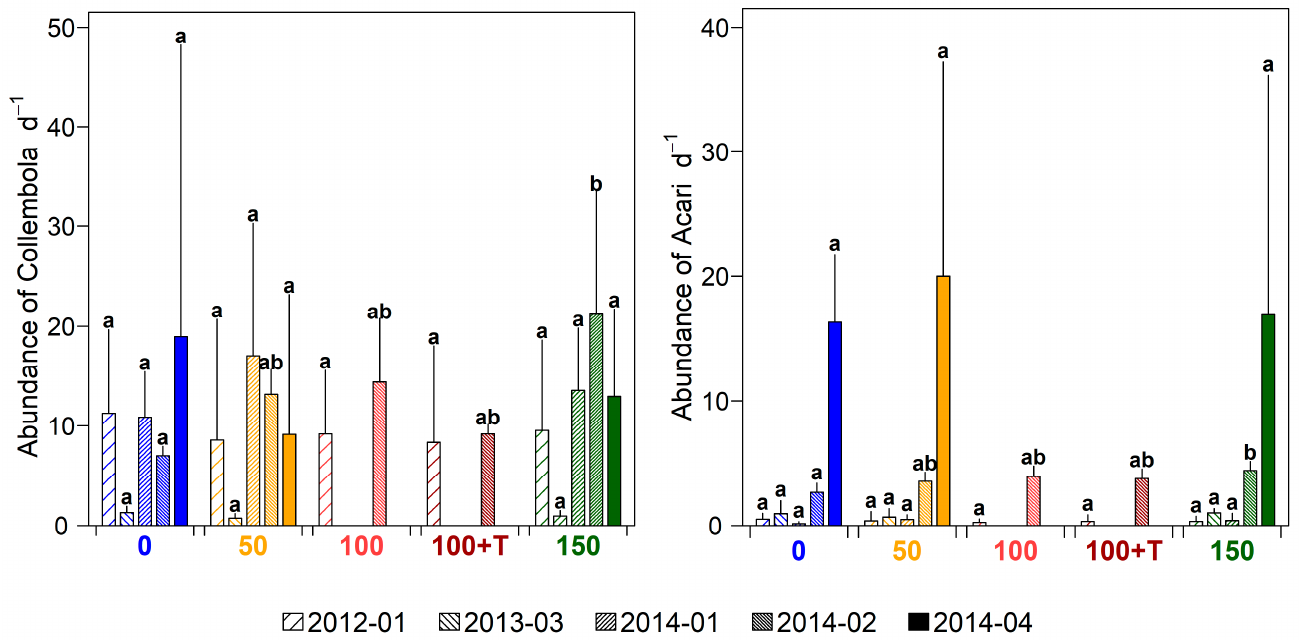
Figure 7. Abundance of Collembola and Acari per sampling day in five scoring events. OMW application rates are 0 (control), 50, 100, and 150 m 3 ha − 1 y − 1 and 100 m 3 ha − 1 y − 1 followed by shallow tillage (100 + T). Different small letters indicate significant differences within one OMW application rate ( p < 0.01).